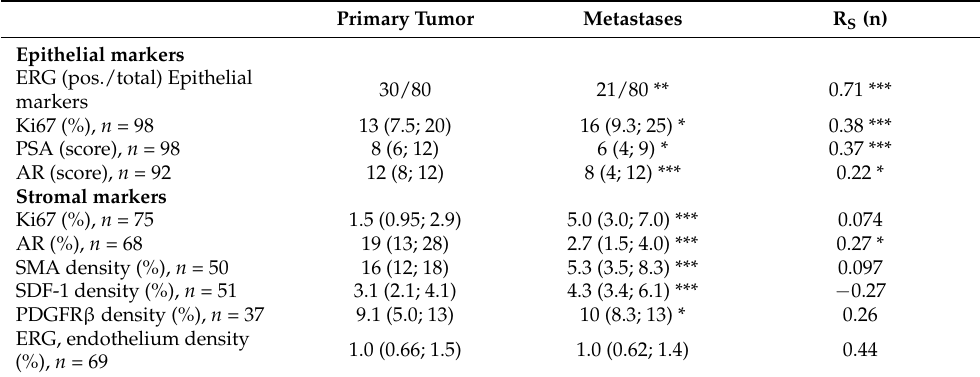
Table 2. Immunoreactivity of selected epithelial and stromal markers of paired primary tumor and metastasis biopsies, sampled with a median time of 1.9 years in-between. Primary Tumor Metastases R S (n) Epithelial markers ERG (pos./total)